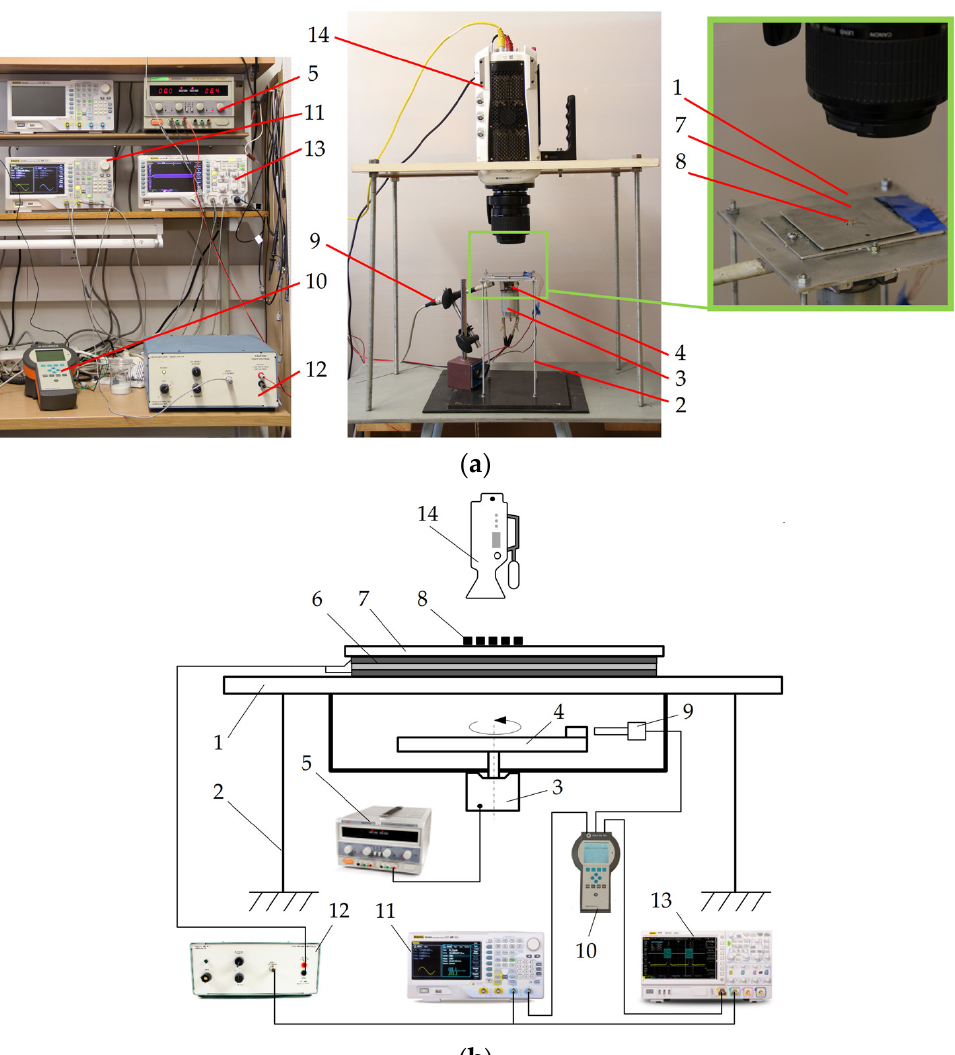
Figure 3. Experimental setup for omnidirectional manipulation applying dynamic dry friction control: ( a ) General view; ( b ) Scheme where the following components are shown: (1) platform; (2) elastic rods; (3) piezoelectric actuator; (4) eccentric mechanism; (5) direct current power supply; (6) piezoelectric actuators; (7) manipulation plate; (8) microparticles; (9) optical reference sensor; (10) vibration analyzer; (11) arbitrary waveform generator; (12) piezo linear amplifier; (13) digital oscilloscope; (14) high-speed camera.